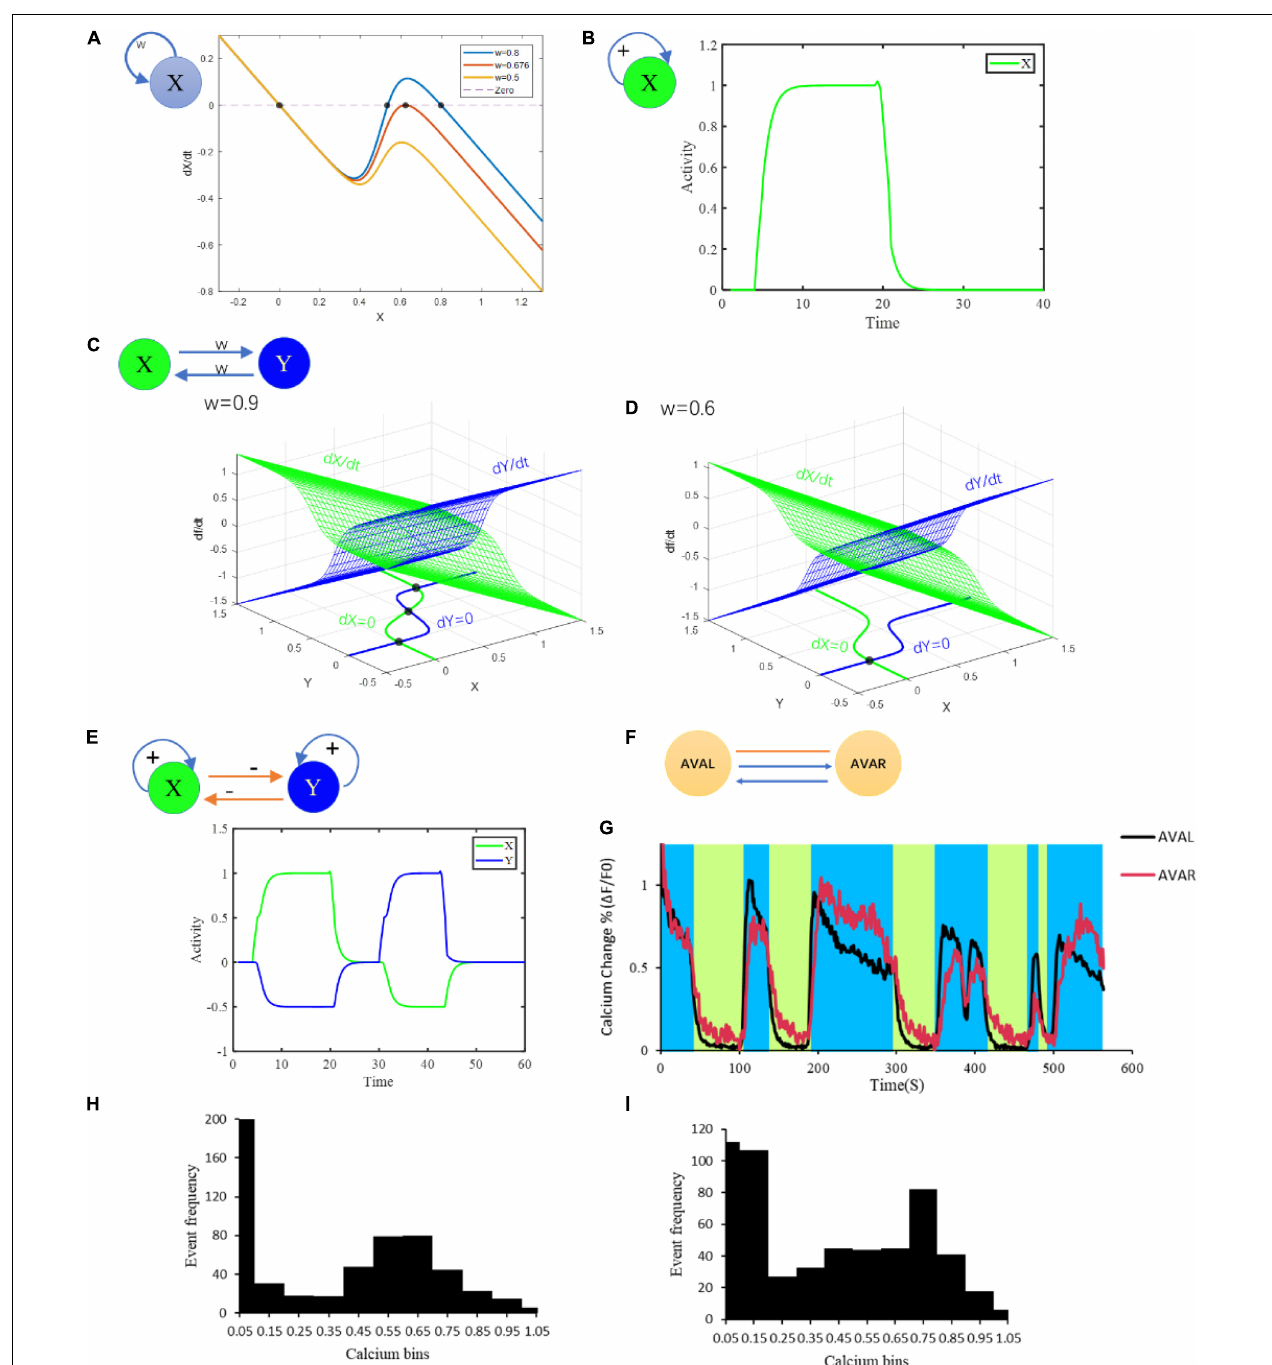
FIGURE 1 | Multiple fixed points generated from different microcircuits. (A) Bifurcation analysis of at most three fixed points of neurons with at least one chemical synaptic self-loop. (B) Bistable activities of a neuron with self-loop. (C) Combined multistability of a complicated circuit composed of two simple motifs inhibiting each other in (B) . (D) Bifurcation analysis of a motif on the condition of strong connection and weak connection. (E) Attraction domains of three fixed points. Red dots represent the fixed points. The lines represent the state trajectories. w means connection strength; + and –represent excitatory and inhibitory connections, respectively. (F) Connection structure of AVAL and AVAR. (G) The neural activity of AVAL, AVAR changes with time. The blue area represents the period when AVAL, AVAR was in high neuro activity, and the light green area represents the period when AVAL and AVAR were in low neuro activity. (H) The distribution of AVAL’s neural activity changes. Its value was normalized. Bin size = 0.1. (I) The distribution of AVBL’s neural activity changes. Its value was normalized. Bin size = 0.1. Structural potential for multiple fixed points.